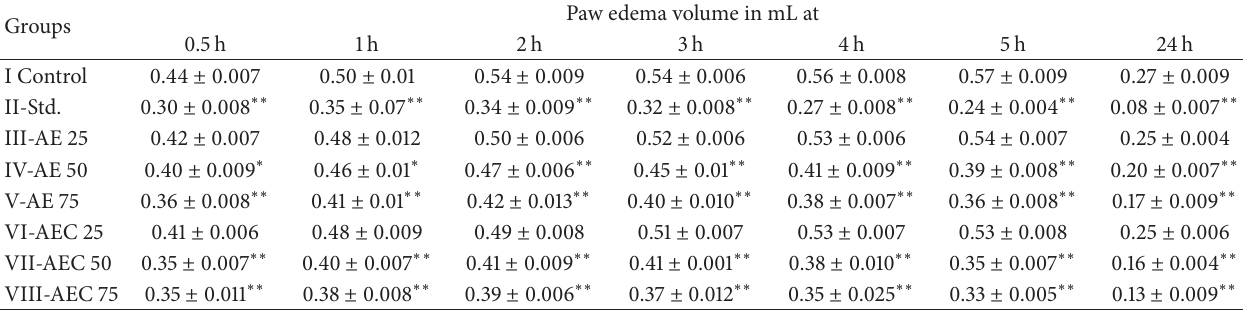
Table 4: Effect of AE and AEC on paw edema volume in carrageenan induced paw edema in rats. Paw edema volume in mL at Groups